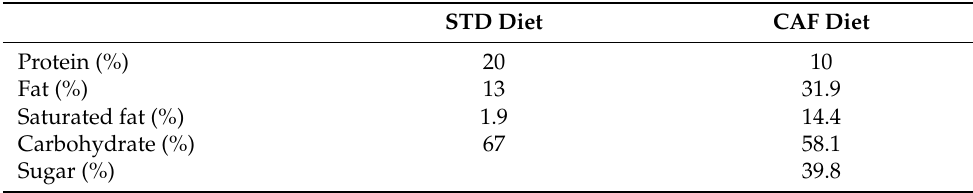
Table 1. Caloric distribution of the